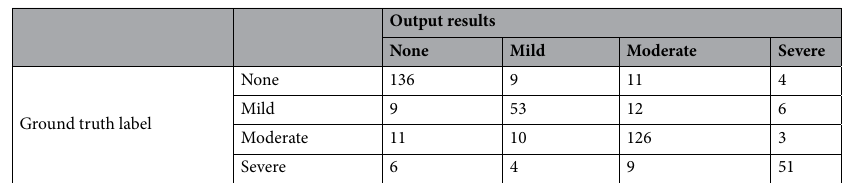
Table 3. Results of pain levels classification using the SVM classifier. Each results were determined by dividing the number of identical sets of predicted (by the machine learning) and actual (NRS) pain levels by whole number of sets in each predicted or actual pain level, respectively.